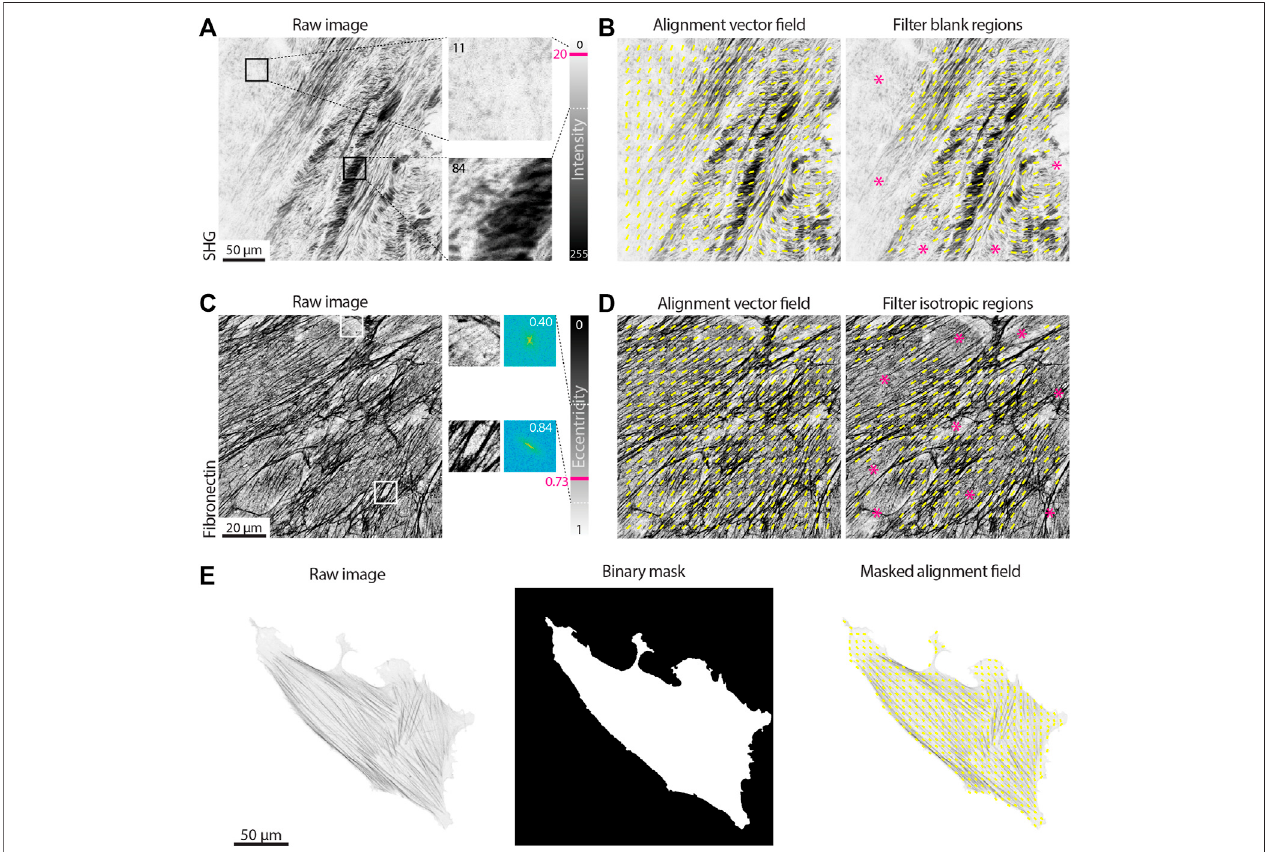
FIGURE7| Filteringvector fi eldsbasedonintensityandeccentricity. (A) Atissuesectionsecondharmonicgeneration(SHG)imageisshown.Tworegionswiththe samesizeofthewindowusedforthealignmentanalysis(100 px )areenlargedandtheirmeanintensityvaluemeasured.Theintensityofan8-bitimagecanvaryfrom0to 255. Theareaonthetop leftcontains littletonosignaland itisconsidered background(mean intensity of11); theareaontheright contains many darkpixels,foramean intensityof84.Athresholdvalueof20isset,meaningthatallwindowswithmeanintensitylowerthansuchvalueswillbeconsideredasblank(i.e.,background)and excluded from the analysis. Scale bar, 50 μ m . (B) The alignment vector fi eld (yellow) is overlaid on the raw SHG image, either without fi ltering for blank regions (left) or fi ltering witha threshold on the meanintensityof20 (right) .Magentaasterisks highlight regions excluded from theanalysis. (C) An immunostaining for fi bronectin in cell- derivedmatricesisshown.Tworegionswiththesame sizeofthewindow usedforthealignment analysis(100 px )areenlargedandtheir2DFastFourierTransform (FFT) displayed. The FFT eccentricity can range from 0 (circular) to 1 (highly elongated). The region on the top lacks clear aligned fi bers, resulting in a more uniform FFT (eccentricity of 0.40); the area on the bottom has aligned fi brillar features, leading to a highly skewed FFT (eccentricity of 0.84). A threshold value of 0.73 is set, meaning that all windows witheccentricity lower than such values will be considered asisotropicand excluded from the analysis.Scale bar, 20 μ m . (D) The alignmentvector fi eld (yellow) is overlaid on the raw fi bronectin image, either without fi ltering for isotropic regions (left) or fi ltering with a threshold on the eccentricity of 0.73 (right) . Magenta asteriskshighlighttheregionsexcludedfrom theanalysis. (E) Theactin inasinglecell isshown.Ifonewantstoexcludethe background from theanalysis, abinarymask can be provided highlighting the regions of the image to be analyzed (window size 50 px with 50 % overlap). Scale bar, 50 μ m